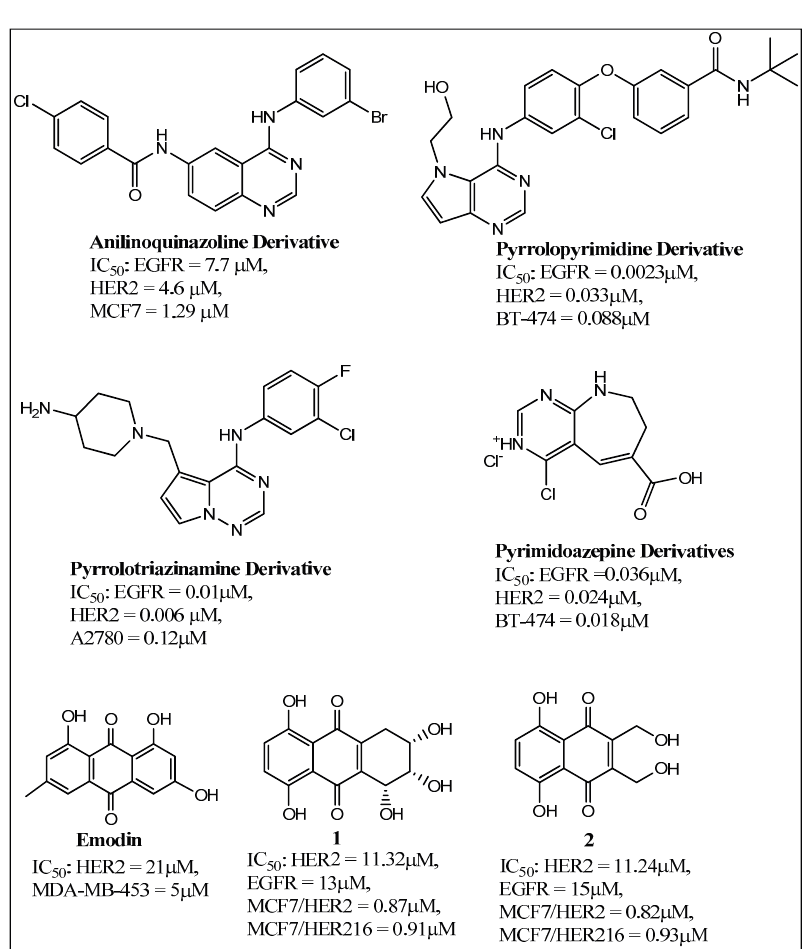
Figure 2. Structures of new HER2 kinase